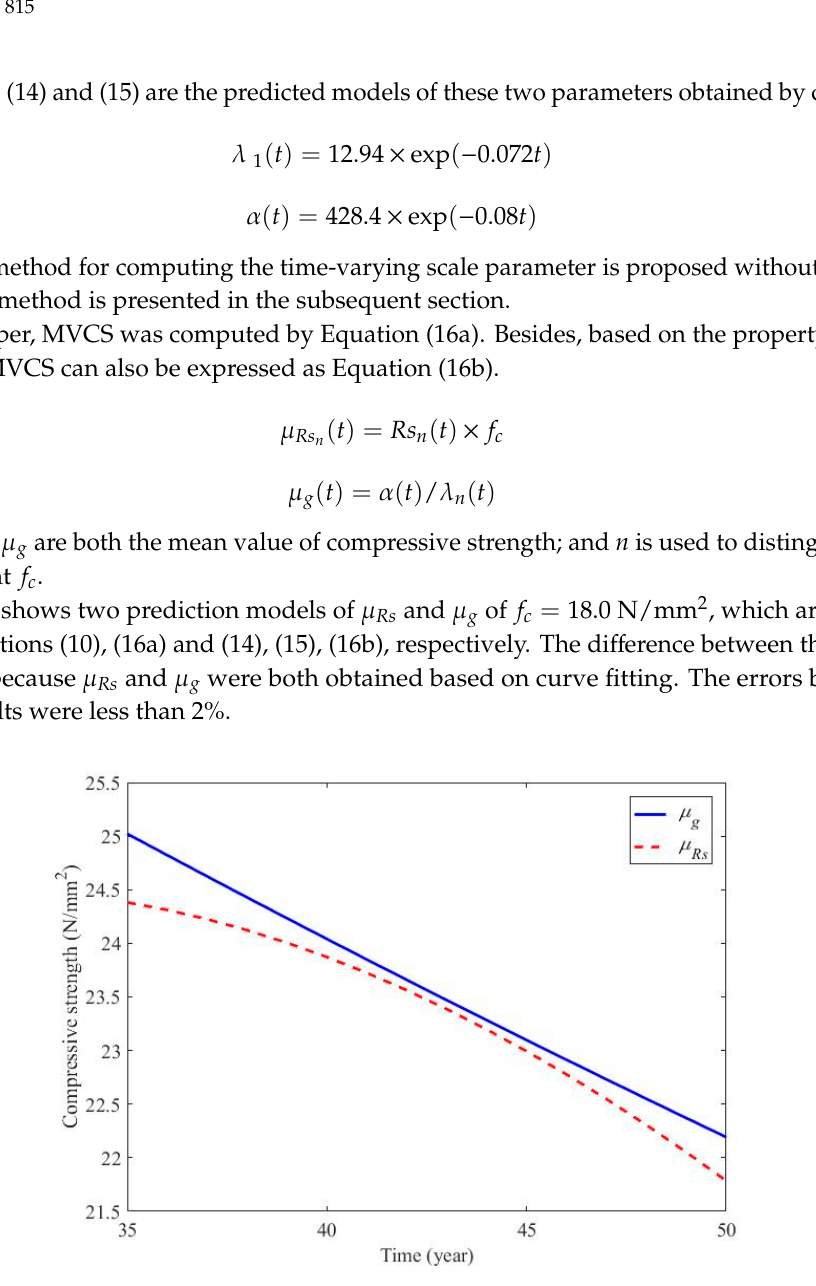
μ μ g f ). and ( 2 N/mm 18.0= c